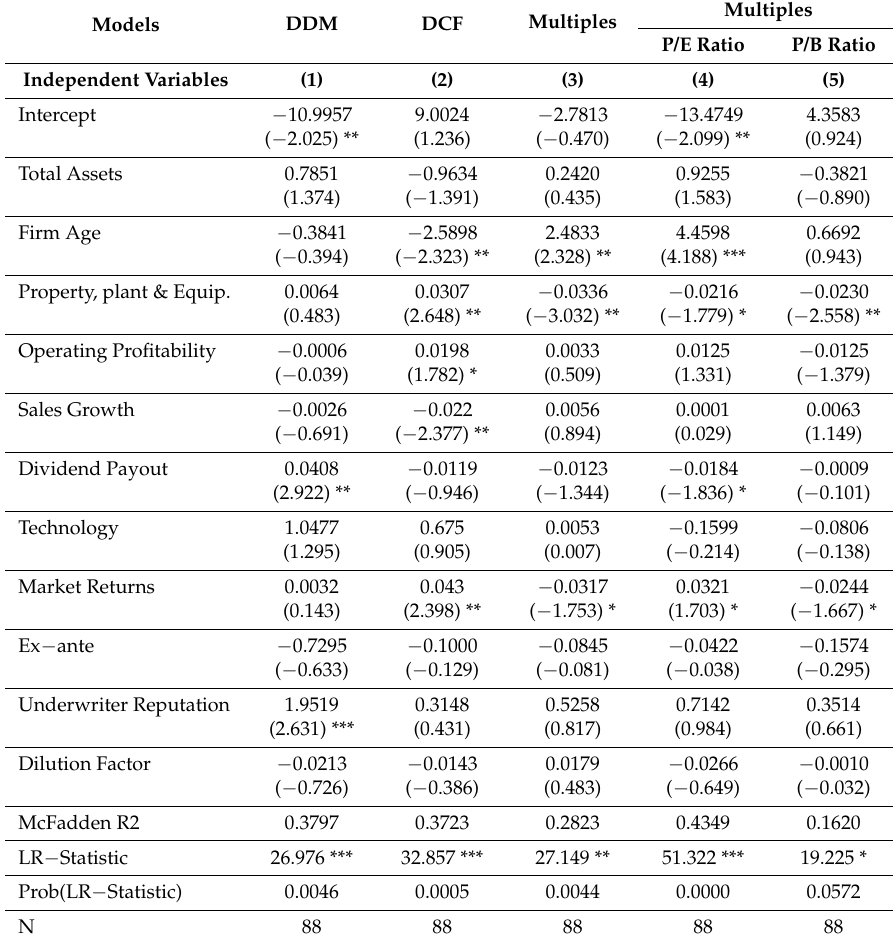
Table 5. Results of Binary Logit of Preferred Valuation